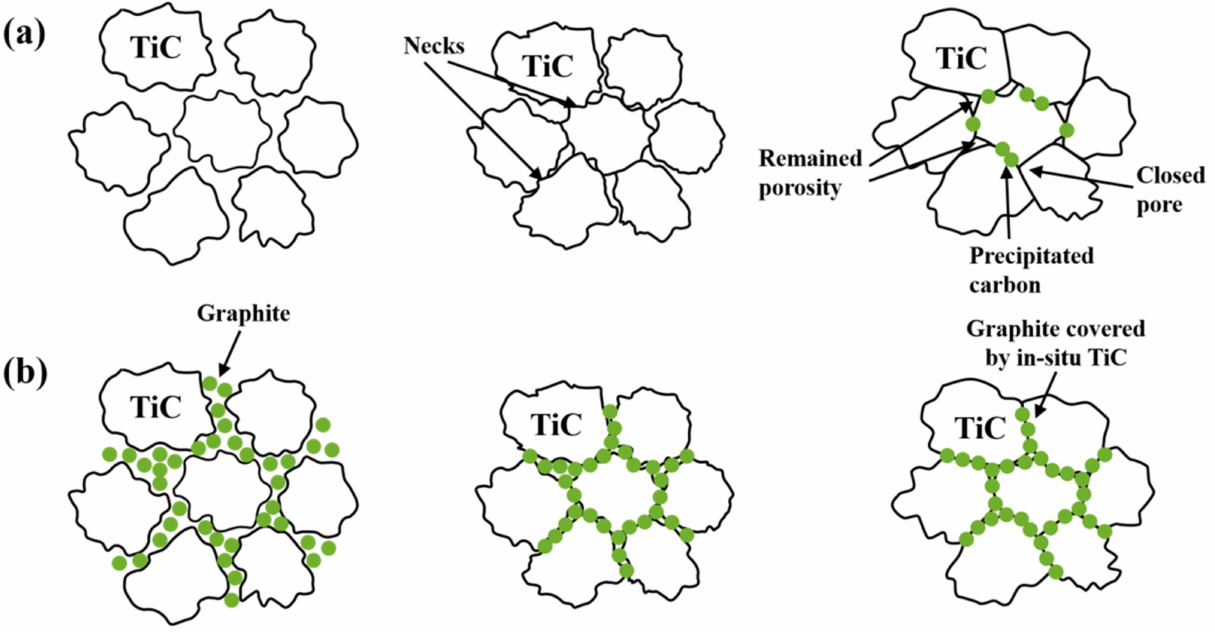
Figure 6. Schematic diagram of sintering and consolidation of TiC ( a ) and TiC-5 wt.% carbon black ( b ) samples